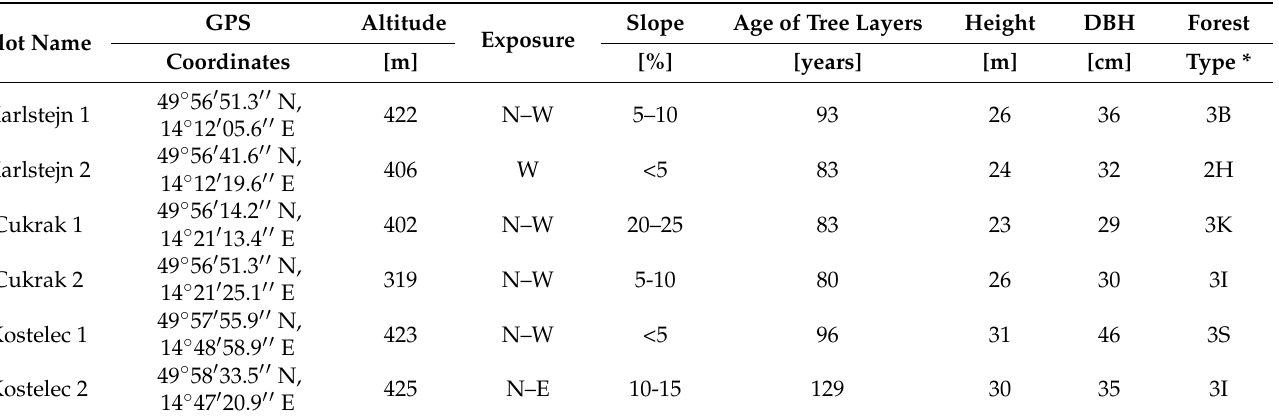
Table 1. Overview of the sites and stand characteristics of research plots (according to the Forest Management Plan).